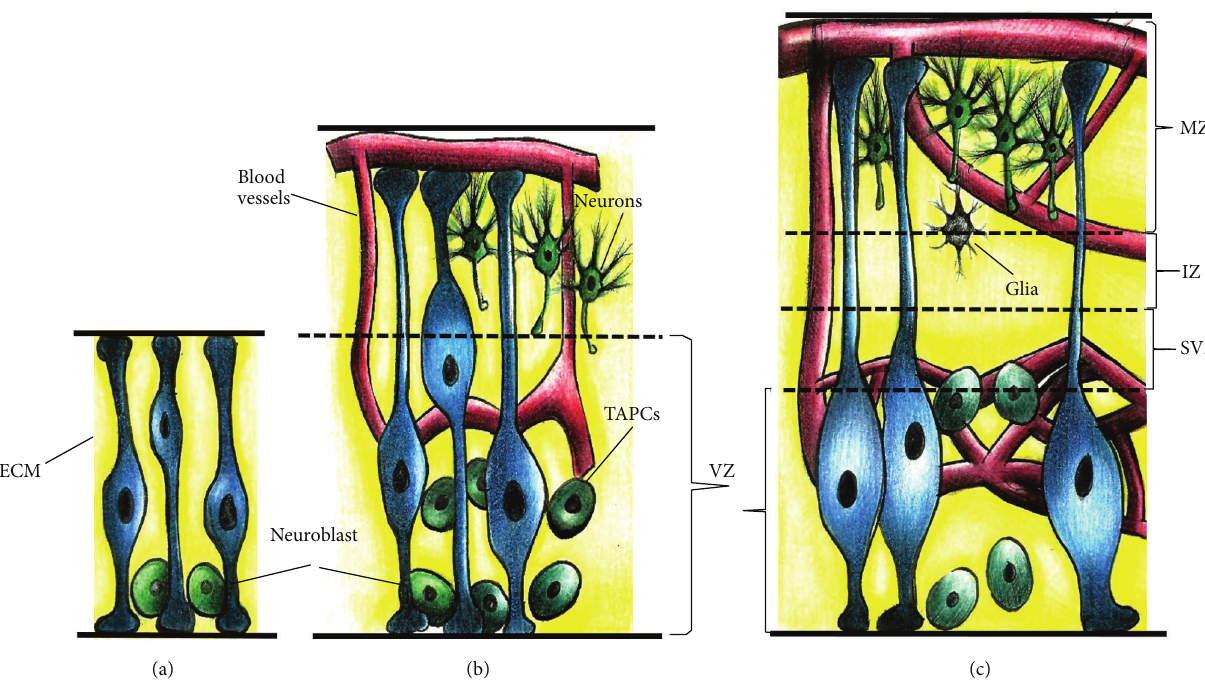
Figure 1: Neural stem cell niche in the early stages of CNS development. (a) During early embryogenesis, neuroepithelial cells transform into radial glial cells (RGCs) with cell process elongating toward the pial surface of the neural tube. RGCs divide asymmetrically to form neuroblasts. (b) Neuroblast division generates progenitors known as “transit-amplifying progenitor cells” (TAPCs), which divide rapidly and generate the first local neural niche or ventricular zone (VZ); at this stage the first blood vessels invade the neural tube from the dorsal region toward the VZ zone and extend their branches tangentially to the pial surface. (c) In the forebrain, TAPC proliferation produces a second germinal zone, the subventricular zone (SVZ). In this zone, postmitotic neuroblasts and glioblasts migrate toward the dorsal intermedia and marginal zones and produce neurons and glial cells. CNS, central nervous system; ECM, extracellular matrix; IZ, intermediate zone; MZ, marginal